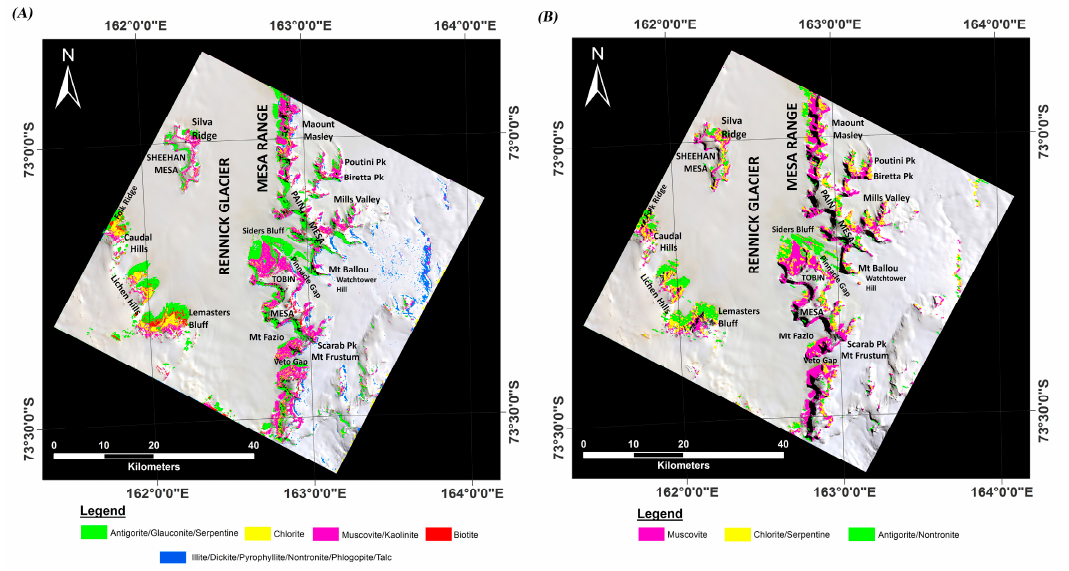
FIG 9 Figure 9. ( A ) CEM classification mineral map for the Mesa Range scene derived from fraction images of the selected endmember minerals using ASTER VINR+SWIR bands. ( B ) CEM classification mineral map for the Mesa Range scene derived from fraction images of the selected endmember minerals using ASTER TIR